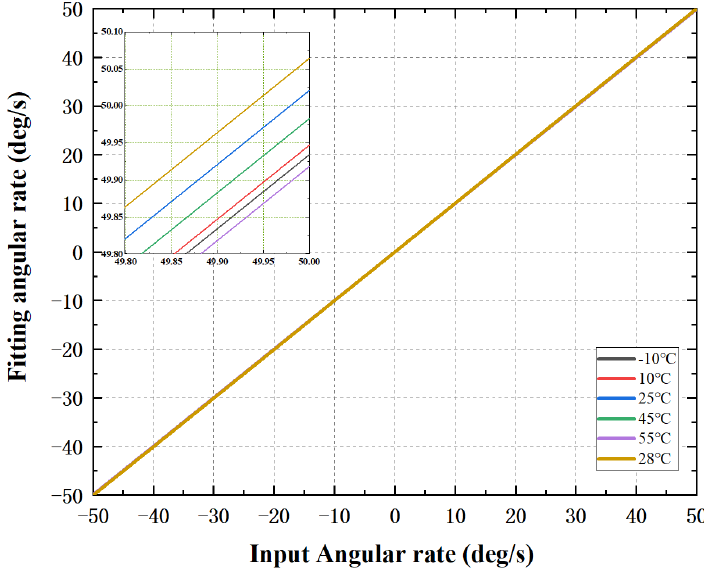
Figure 9. Fitting angular rate vs. input angular rate (070076).